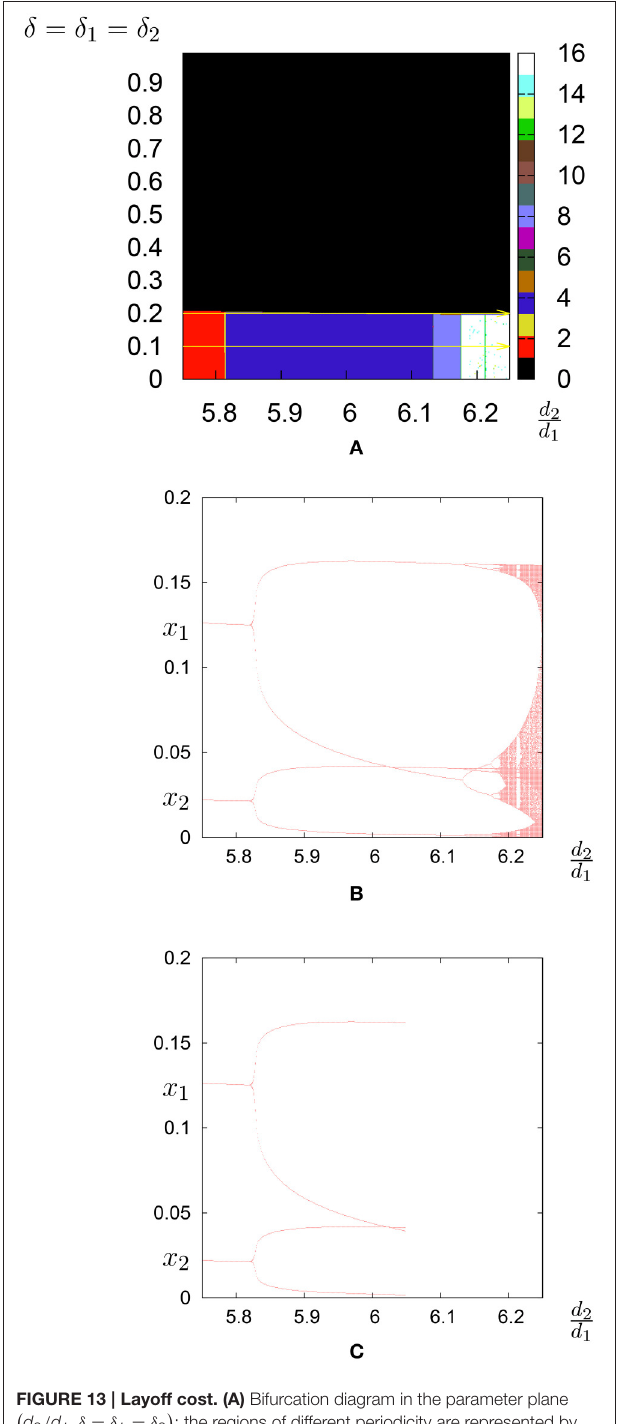
δ 1 δ 2 0.1 and in (C) , the = = = δ 1 δ 2 = = =